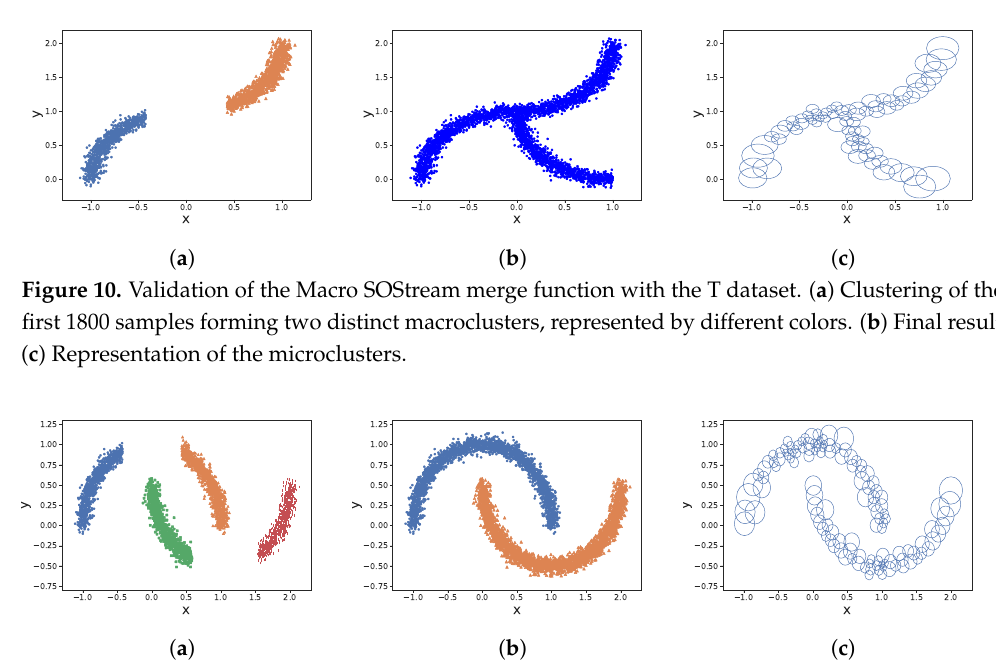
Figure 11. Clustering of the Moon dataset with Macro SOStream. ( a ) Clustering of the first 3500 samples forming four distinct macroclusters, represented by different colors. ( b ) Final result with two macroclusters. ( c ) Representation of the microclusters.